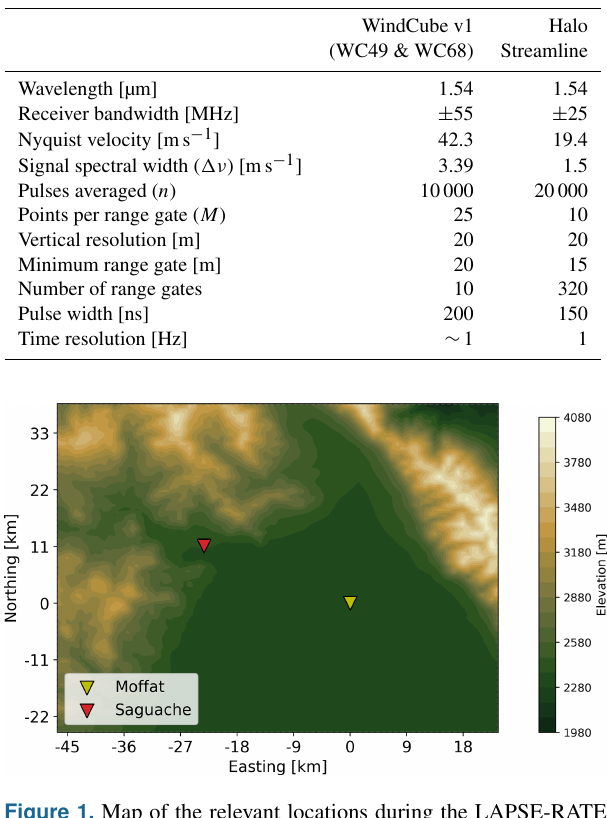
Figure 1. Map of the relevant locations during the LAPSE-RATE field campaign. Elevation contours are shown every 100m. Dis- tances measured from the Moffat